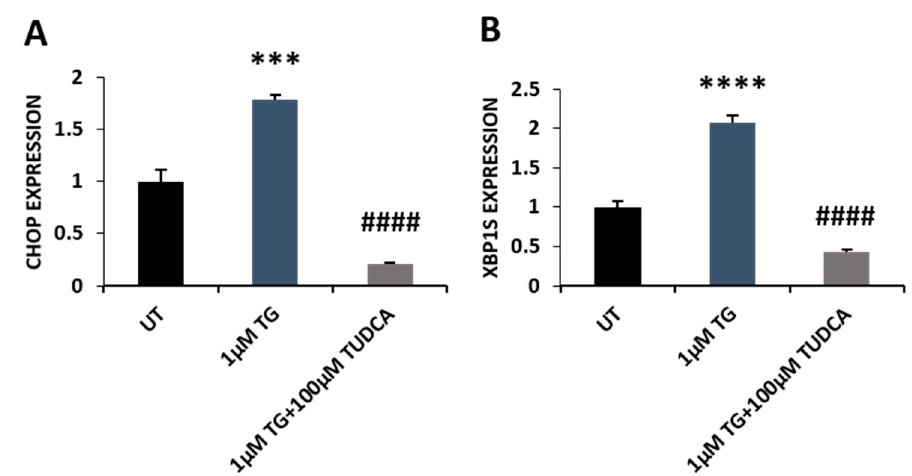
Figure 7. TUDCA suppressed TG-induced expression of ER sensors. ( A ) CHOP expression in untreated (UT) control, TG, and TG-plus-TUDCA-treated cells was examined by qRT-PCR. ( B ) Spliced XBP1 in untreated and treated cells was detected by qRT-PCR. Values were mean ± SEM. *** p < 0.001, **** p < 0.0001, 1 µM TG vs. UT; #### p < 0.0001, 1 µM TG plus TUDCA vs. 1 µM TG.